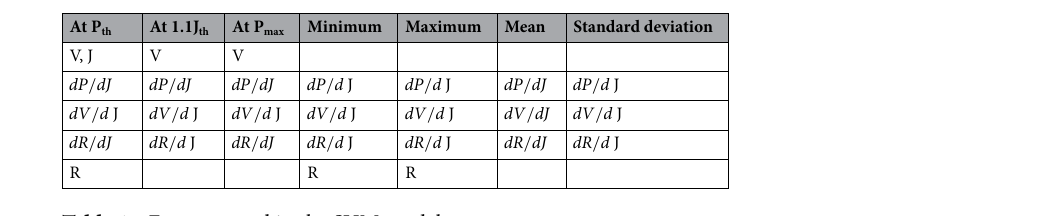
Table 1. Features used in the SVM